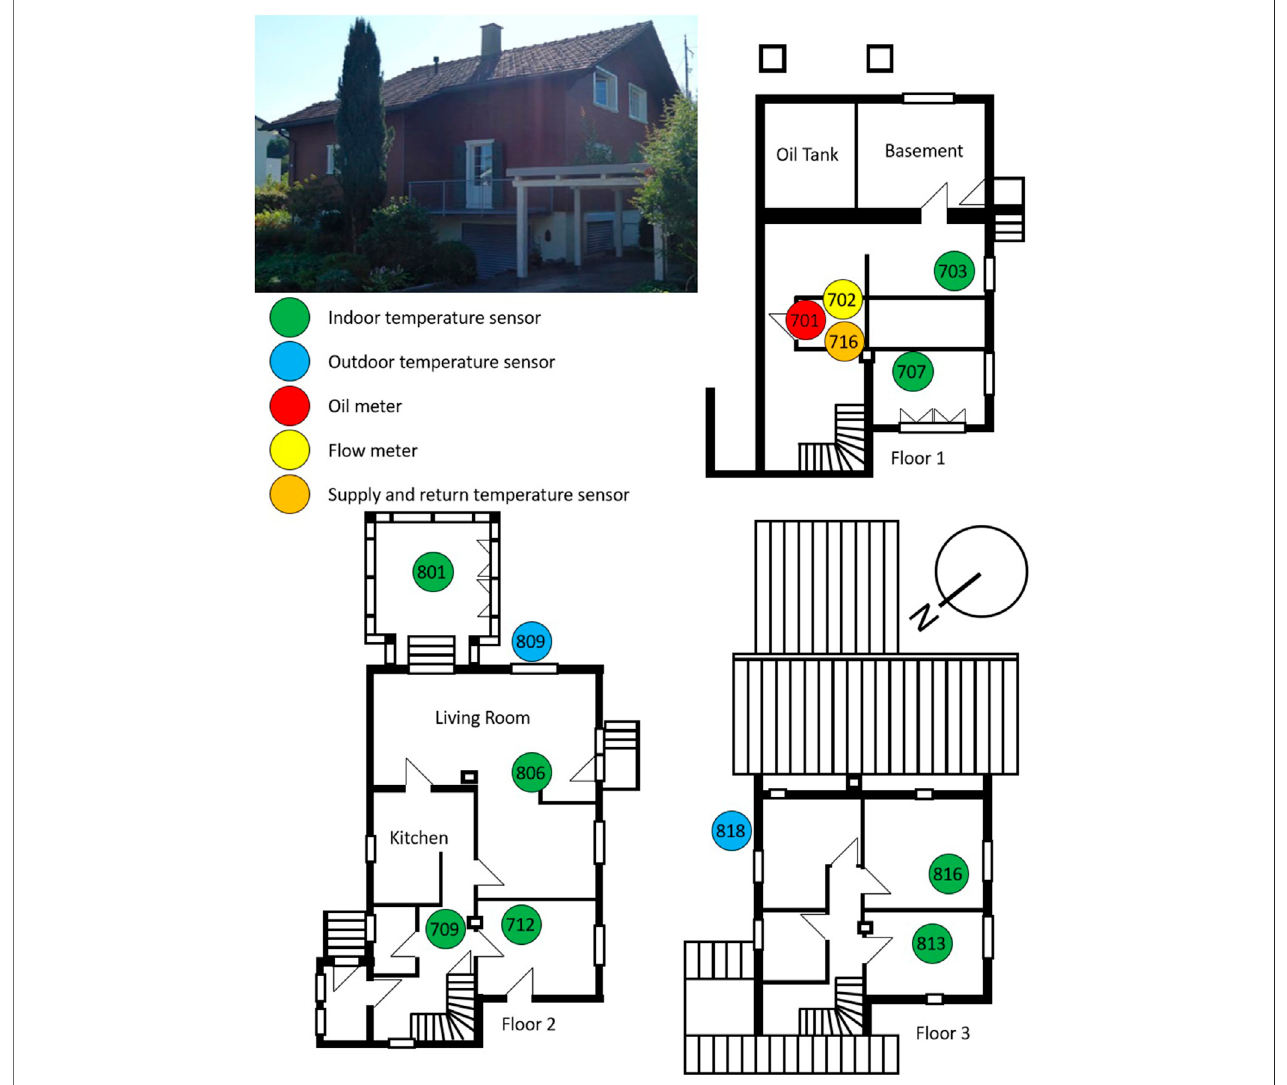
FIGURE 3 | Case study overview: a recent photo of the residential building case study in St. Gallen, Switzerland (left, view from west) and the fl oor plans with indications of where various sensors were installed.